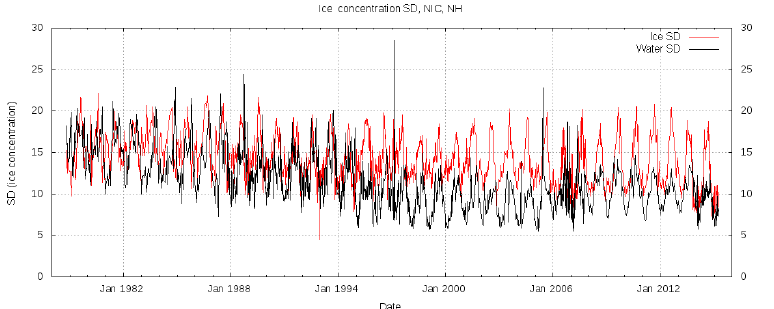
Figure 5. The Arctic ESICR–NIC ice chart standard deviation of the difference for areas of ice in red and for areas of open water in black.